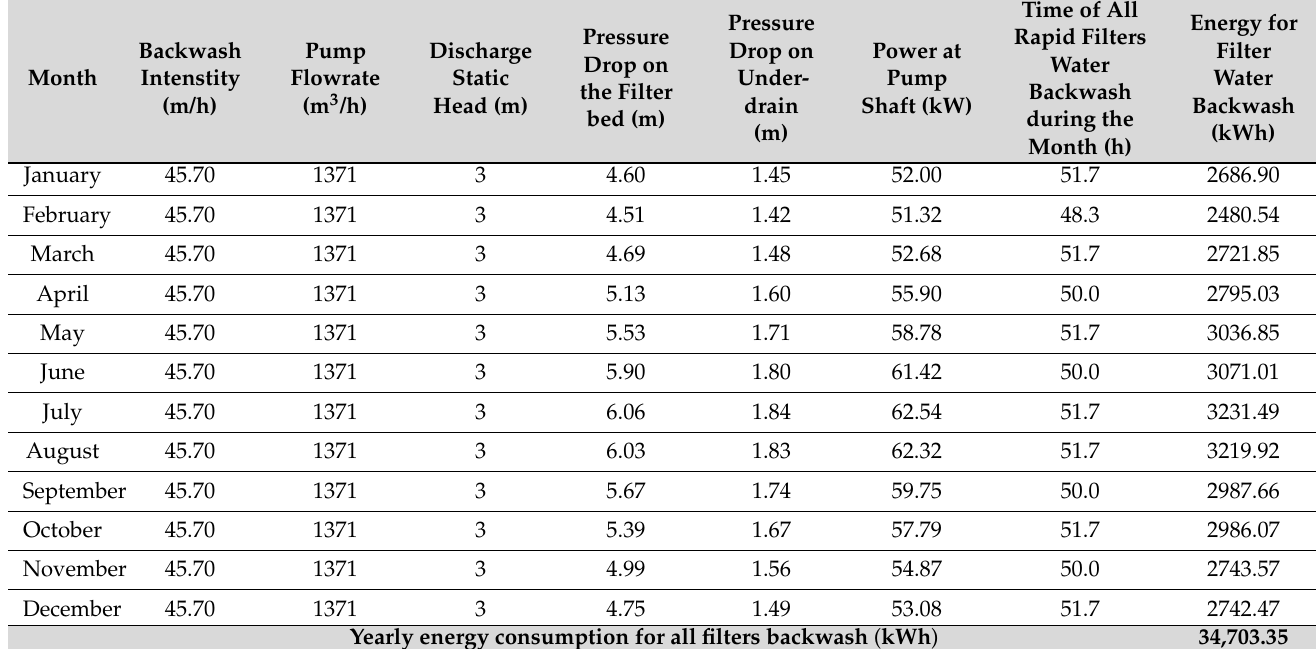
Table 6. Energy consumption for backwashing of rapid filters without monthly adjustment of the backwash intensity to water